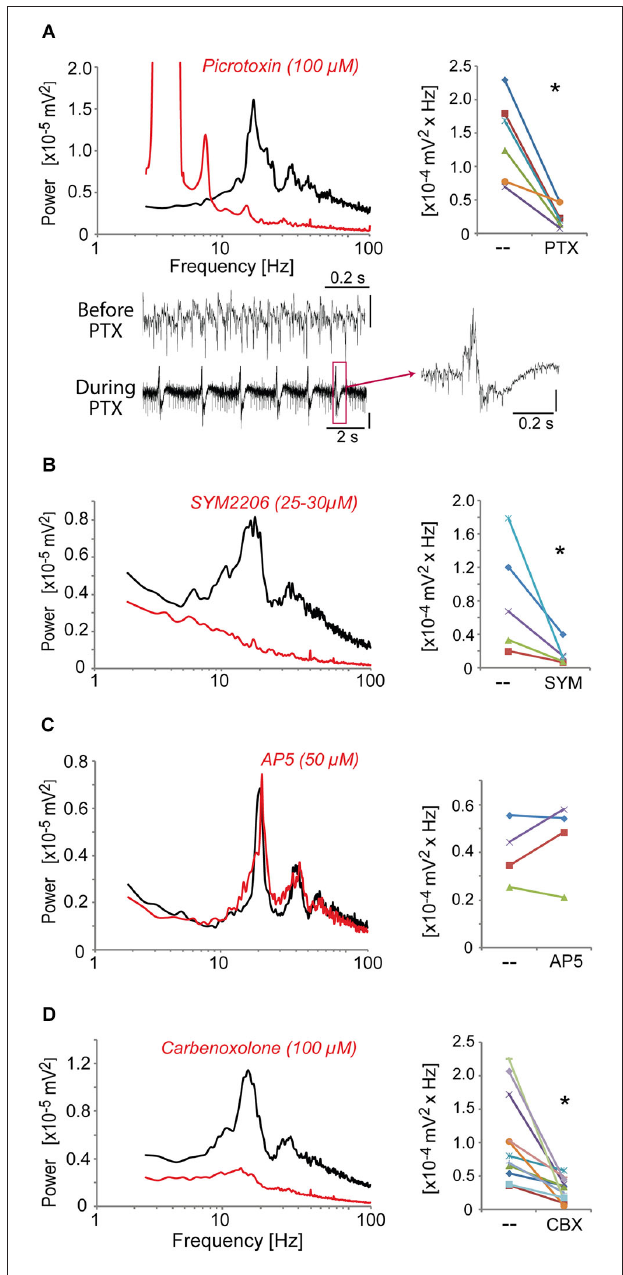
FIGURE 4 | The fast oscillatory activity that is elicited by a mixture of quinpirole, kainate and carbachol (Quinp/KA/Carb) requires activation of GABA A receptors, AMPA receptors, and functional gap junctions. (A) Inhibition of GABA A receptors (with picrotoxin, PTX, 100 µ M, for 30 min) abolishes the high-frequency oscillations (one-tailed, P = 0.0025, n = 6). Traces show recordings before and during PTX application. Note the regular epilepticform activity following PTX superfusion. The right trace shows one of these epileptic-like events. Vertical scales: 0.1 mV. (B) Inhibition of AMPA receptors (with SYM2206, SYM, 25–30 µ M, for 40 min) abolishes the oscillations (one-tailed, P = 0.023, n = 5). (C) Inhibition of NMDA receptors (with AP5, 50 µ M, for 40 min) does not affect the oscillations (one-tailed, P > 0.05, n = 4). (D) Functional impairment of gap junctions (with carbenoxolone, CBX, 100 µ M, for 60 min) abolishes the oscillations (one-tailed, P = 0.007, n = 11). Left graphs: power spectra of